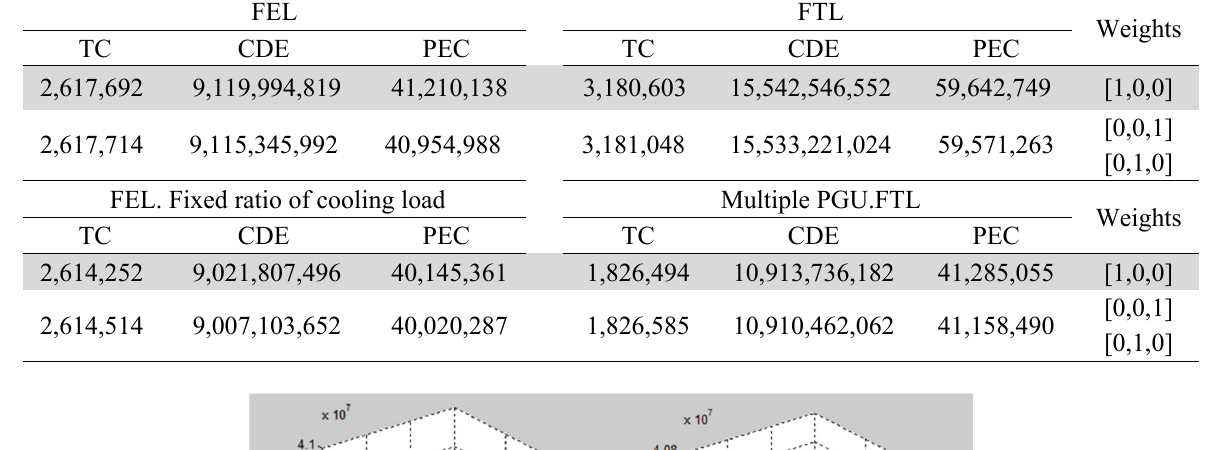
Results of different strategies in thresholds